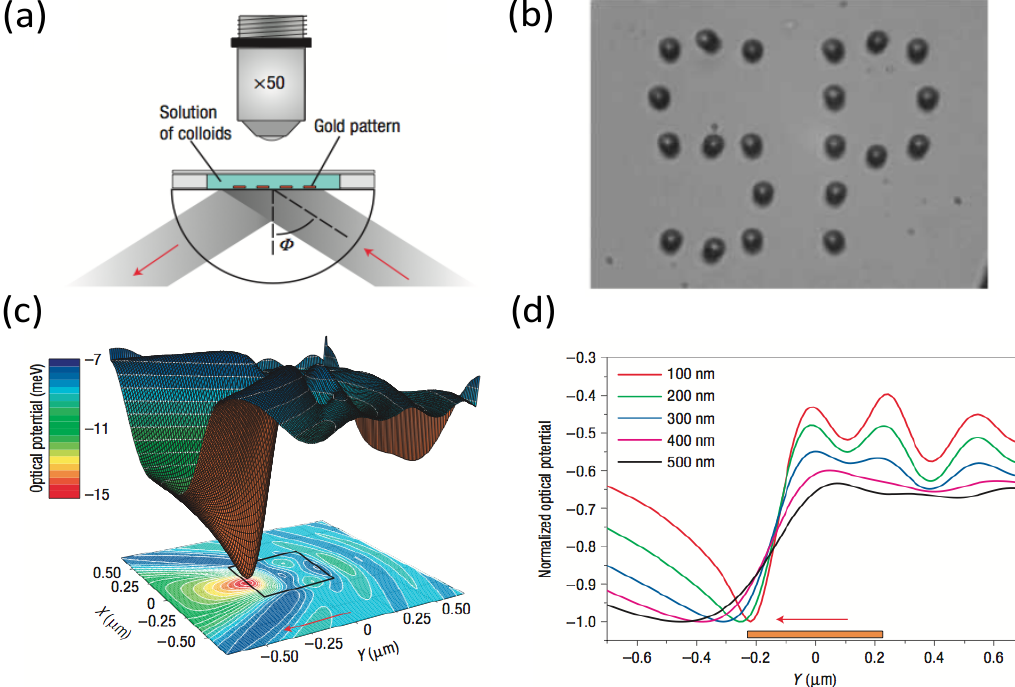
Figure 1. Plasmonic optical tweezers (POT). ( a ) Schematic diagram of typical optical configuration with prism coupling; ( b ) Arrangement of polystyrene microbeads on a patterned substrate after laser illumination at the surface plasmon resonance; ( c ) Computed optical potential landscape for a 200-nm polystyrene bead near a 0.45- μ m-sided square gold pad; ( d ) Cross-sections of optical potential energy along the Y direction computed for different bead sizes. Reproduced with permission from [16]. Copyright 2008, Nature Publishing